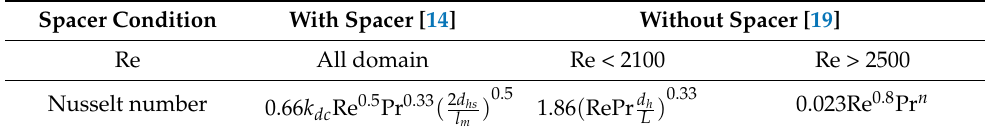
Table 1. Nusselt number formula for different spacer